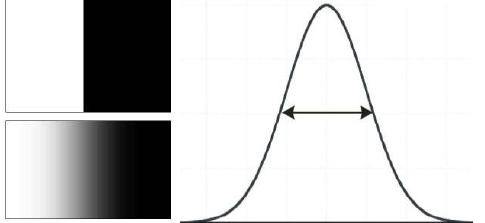
Figure 9: left: edge in object space and in image space, right: point spread function